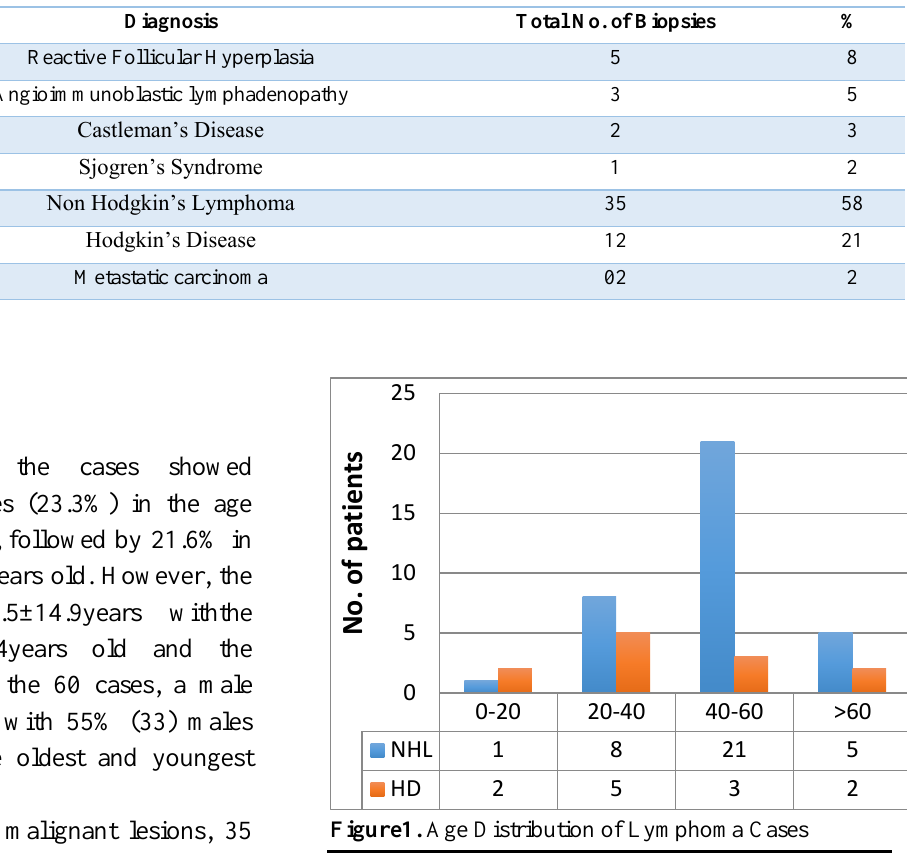
Table 1. Distribution of Cases According to Diagnosis